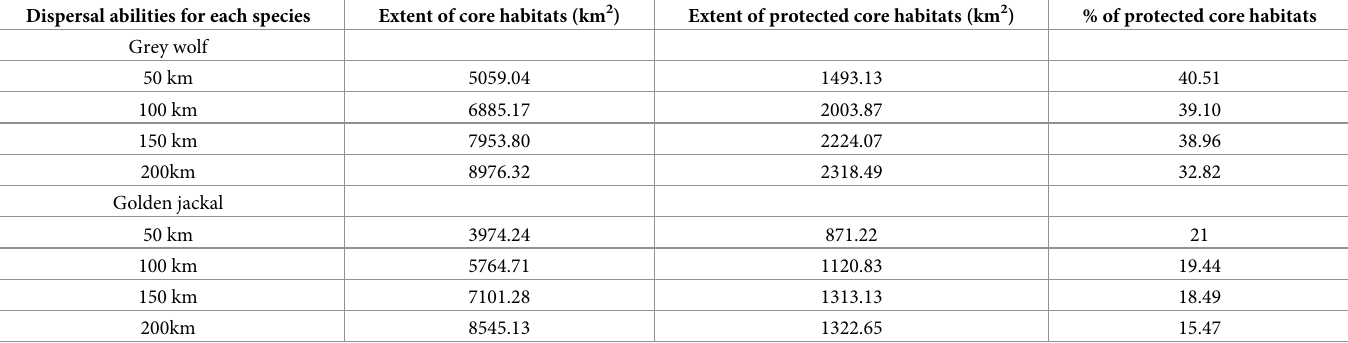
Table 2. The extent and percent of core habitats covered by current conservation networks for grey wolf and golden jackal in Central Iran. The median value of hab- itat suitability for presence points was used as the threshold to define the highly suitable habitats. Dispersal abilities for each